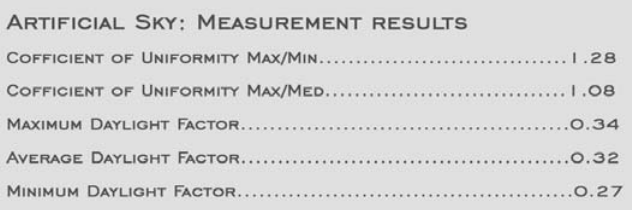
Figure 10. Results of the measurements of artificial sky.